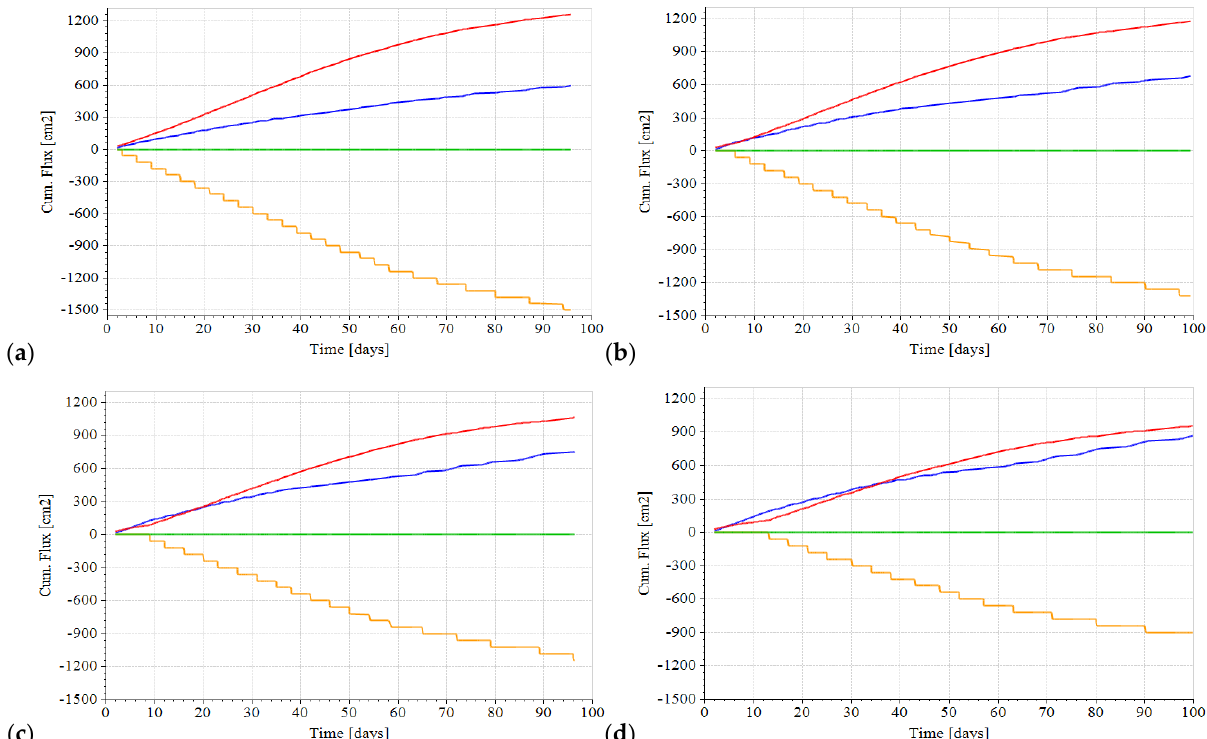
Figure 7. Cumulative root water uptake, evaporation, free drainage, and variable fluxes for ( a ) T 90, ( b ) T 80 , ( c ) T 70 , and ( d ) T 60 when activating root growth option.